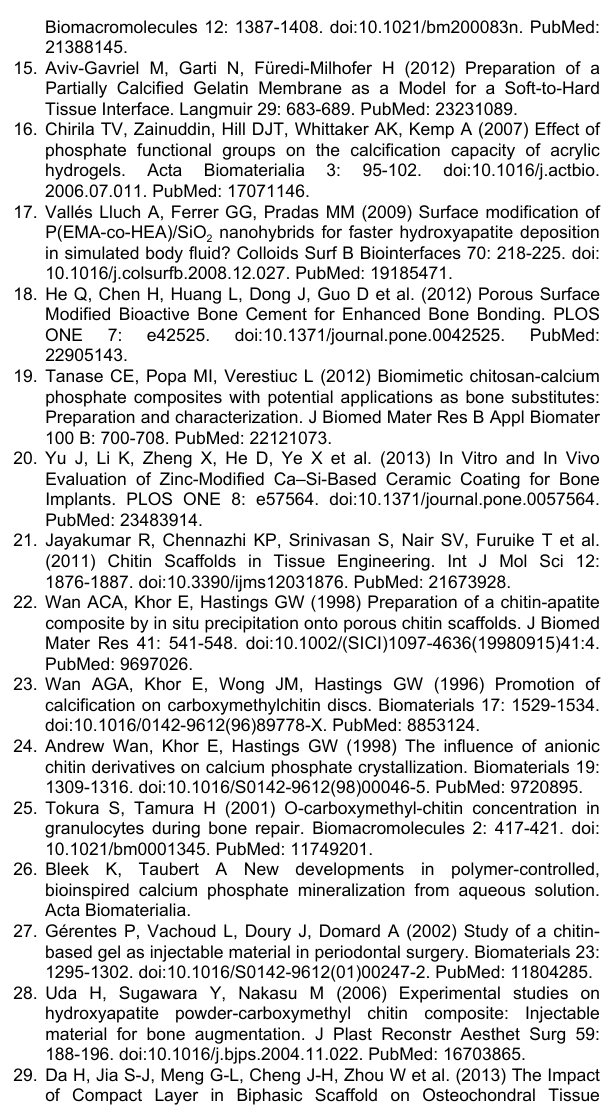
Figure S1. SEM micrograph of scaffold construct treated entire defect site after week 10. The micrograph demonstrates the interfacial interaction of newly formed bone and its structural integration, mimicking old bone. OB: old bone, NB: new bone, IF: interface. Scale Bar: 10 µm. (TIF) Video S1. Scaffold’s viscoelastic behavior (AVI).